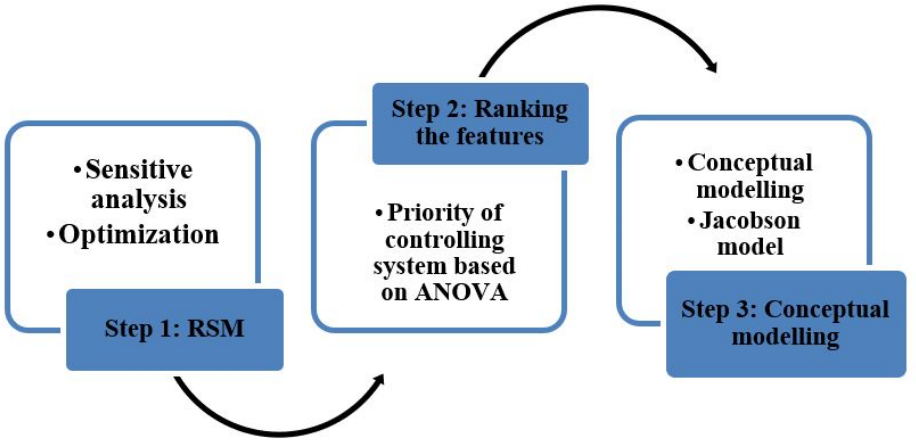
Figure 2. Figure 2. The structure of conceptual modelling by means of the Jacobson technique in the present research.